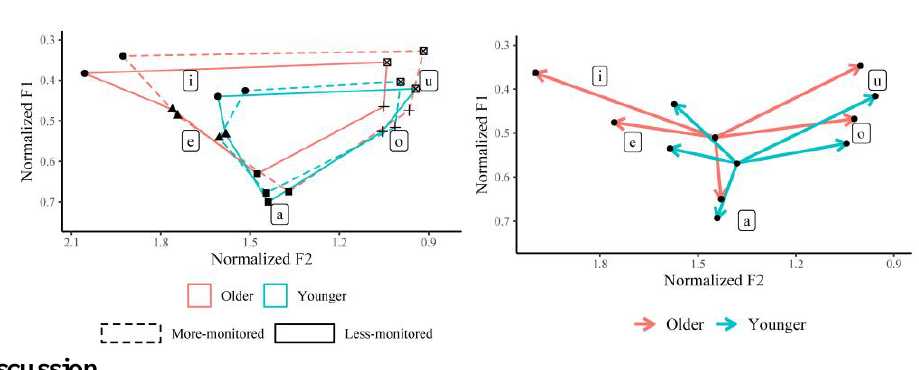
Figure 5. Left : Bay Area Spanish vowel space across age and style; Right : Bay Area Spanish vowel space dispersion across